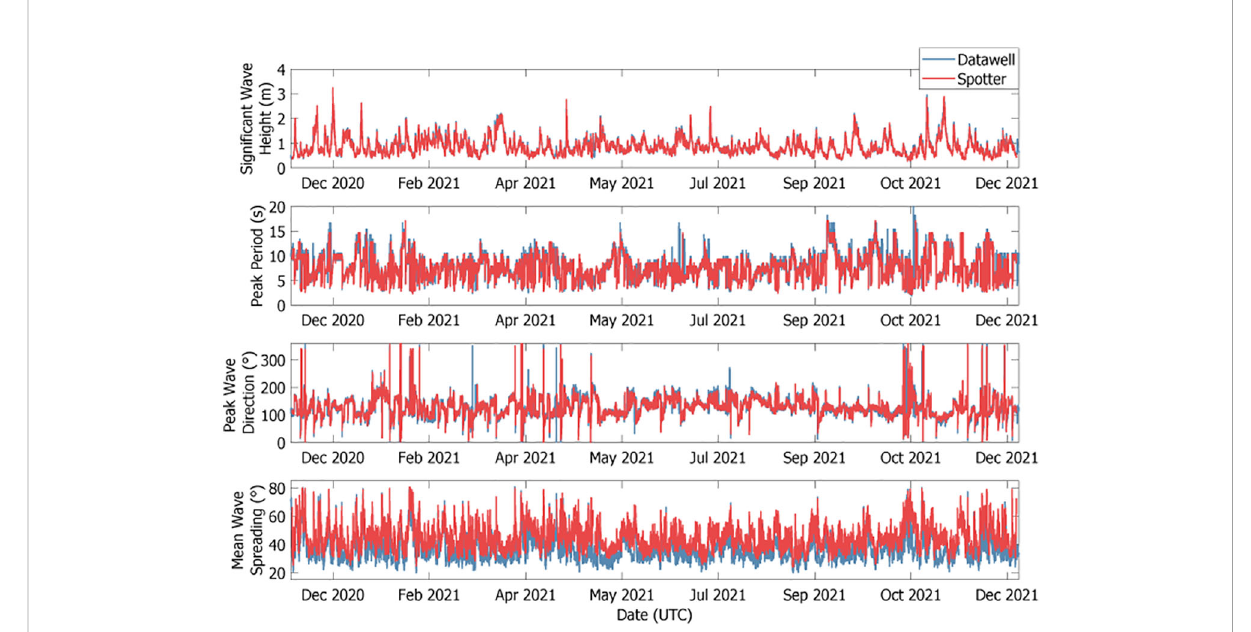
FIGURE 3 Time series plots comparing bulk wave statistics reported by the Datawell and Spotter wave